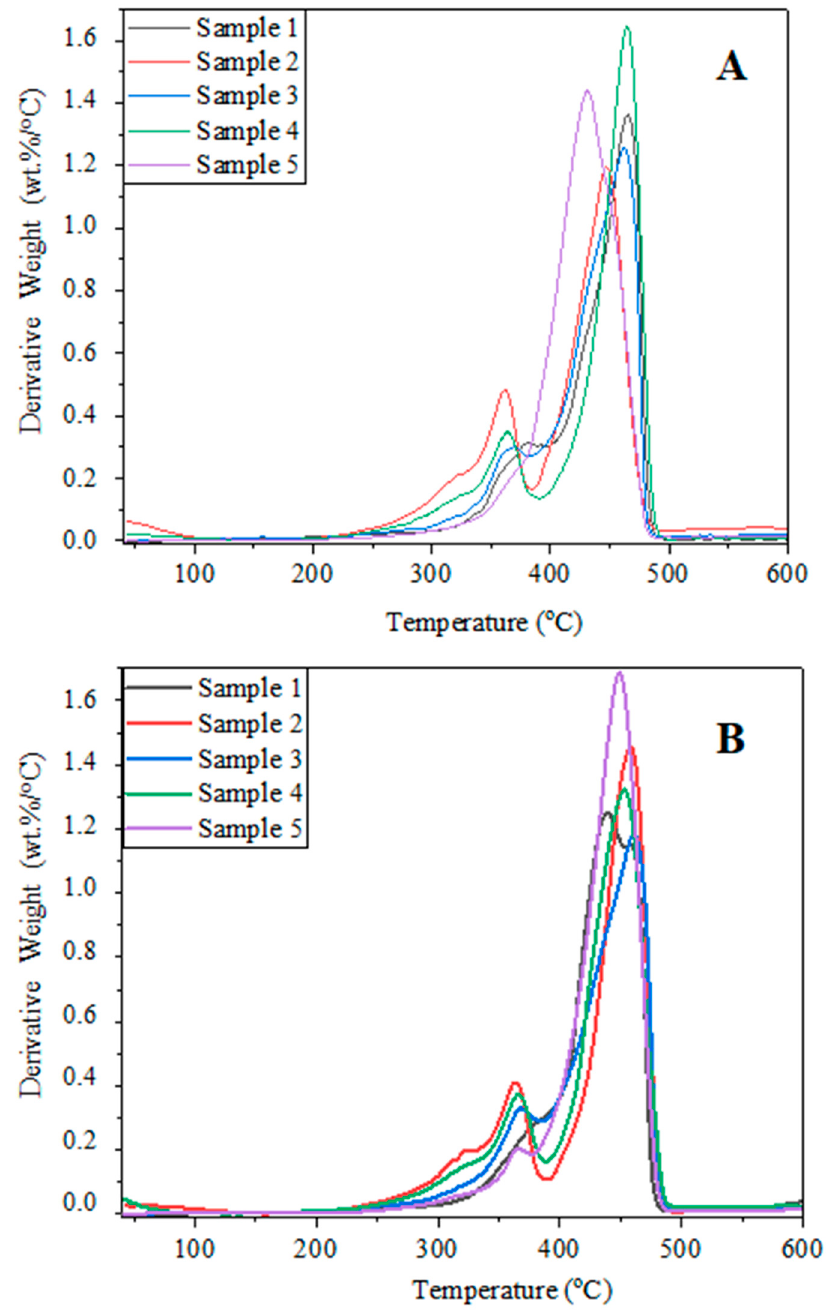
Figure 2. Thermogravimetric analysis results of the untreated ( A ) and EB compatibilized ( B ) PP/GTR/WF